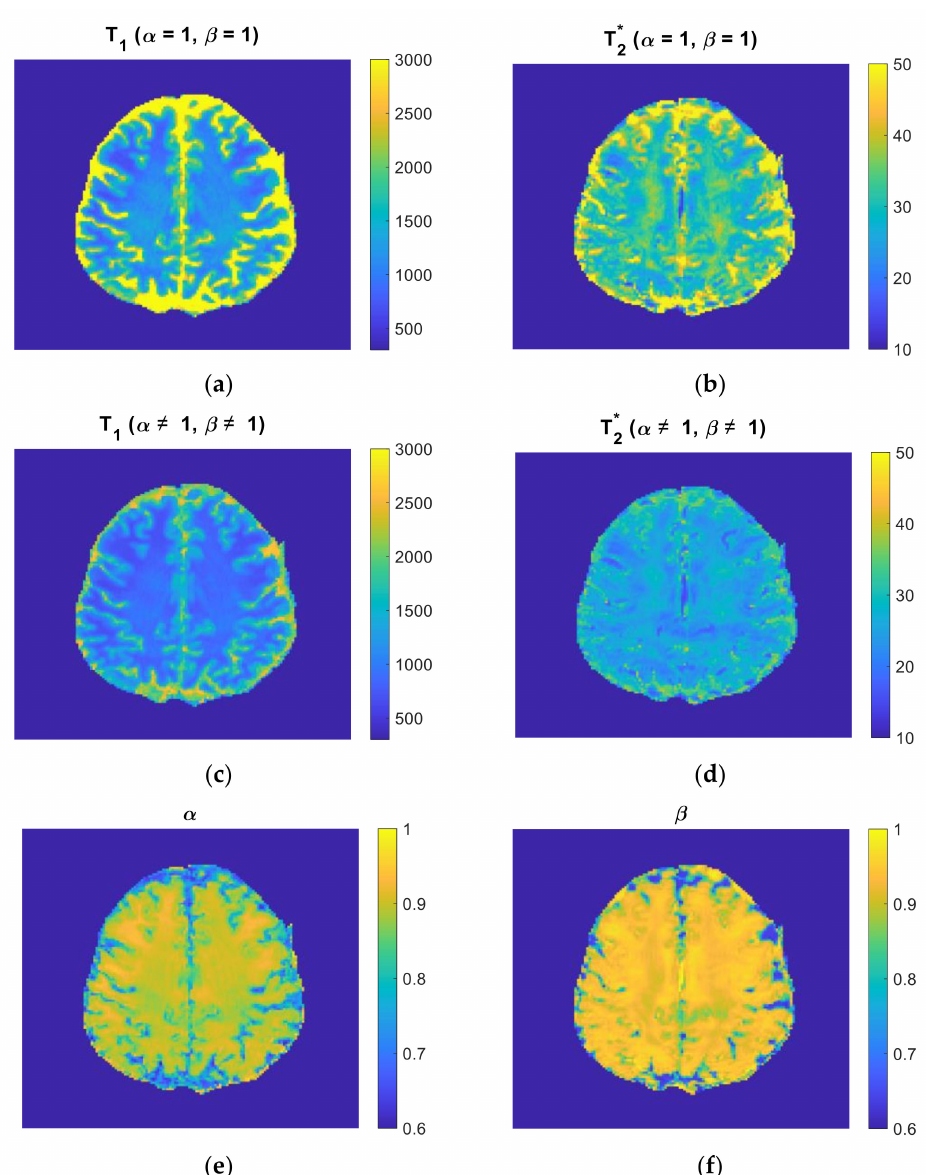
Figure 7. A second example of spatially resolved maps of model parameters (slice 50, participant 4). Displayed are ( a ) T 1 and ( b ) T ∗ for the integer order model. Additionally, time fractional order 2 parameter model parameters ( c ) T 1 , ( d ) T ∗ , ( e ) α and ( f ) β are 2